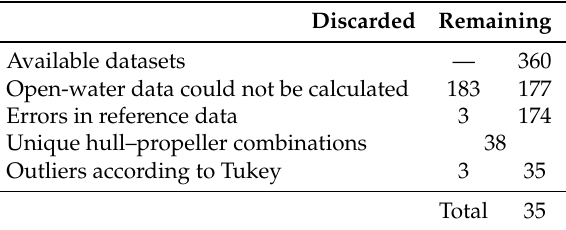
Table 6. Number of used